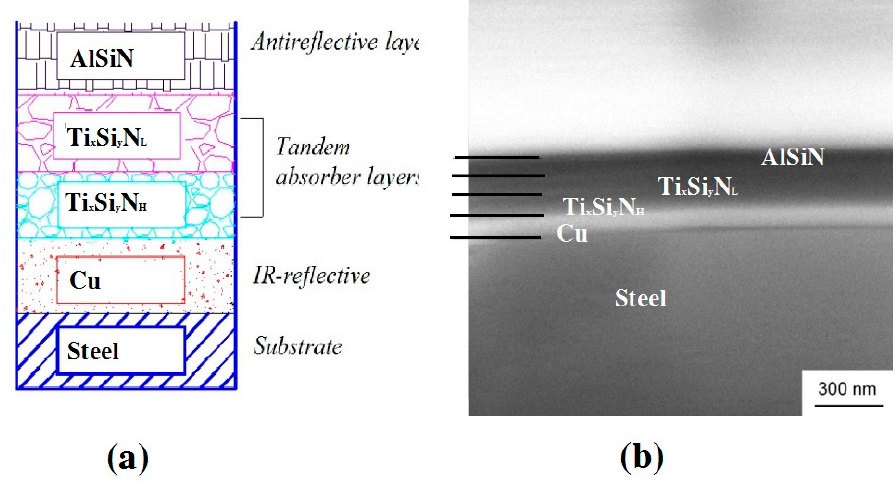
Figure 2. ( a ) Schematic diagram, and ( b ) cross-section microstructure of solar selective coatings (SSC).